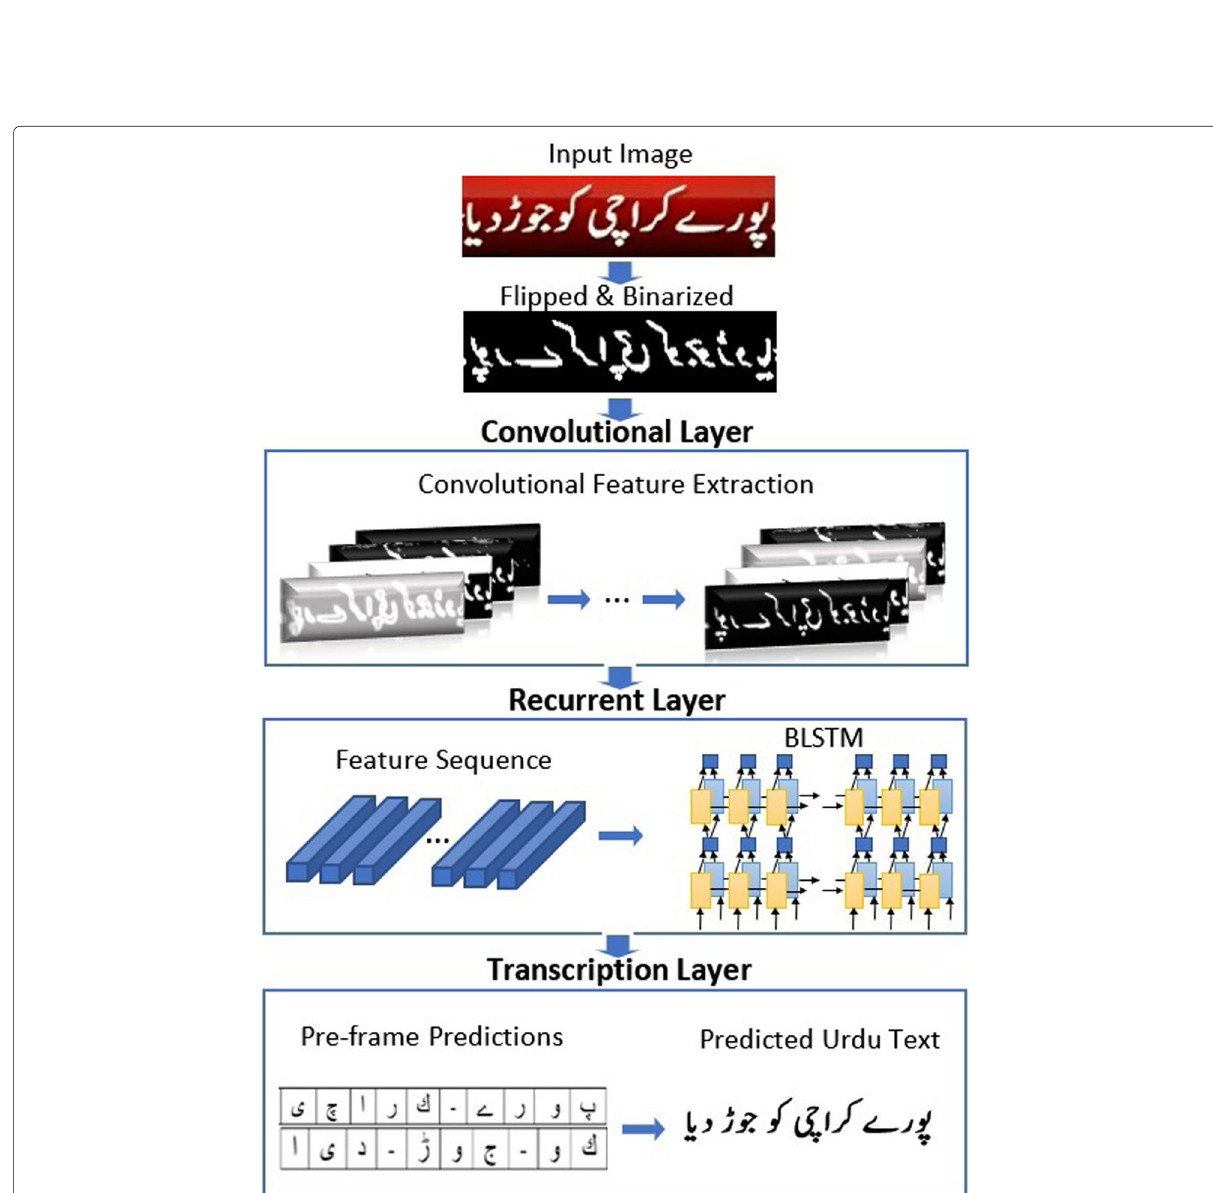
Fig. 10 UrudNet: overview of steps involved in recognition of text